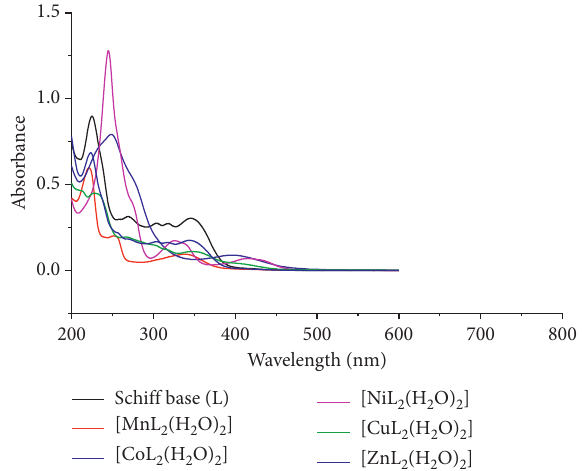
Figure 3: UV-Vis spectra of Schiff base ligand and its metal (II)